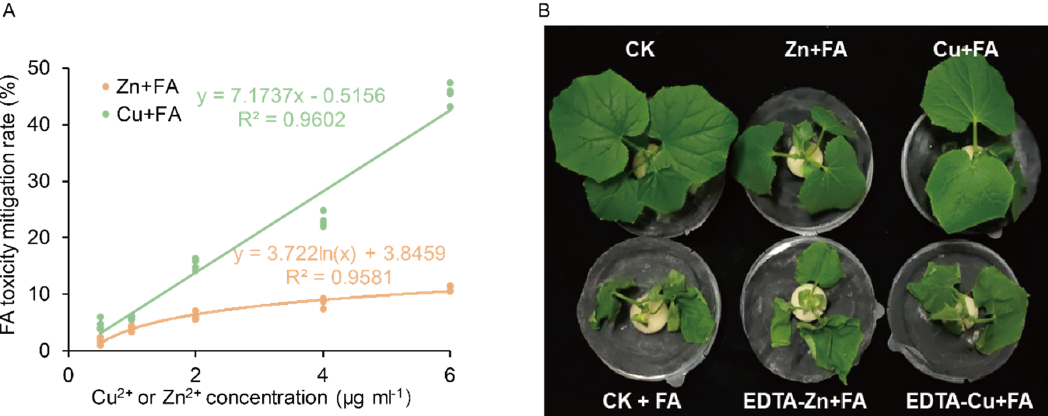
Figure 4. Ions mitigated toxicity of FA in vitro. ( A ) CuSO 4 and ZnSO 4 as resources of Cu and Zn were mixed in the FA aqueous solution (2 µg mL − 1 ) for 24 h. Zn or Cu concentrations were 8, 16, 32, 64 and 96 µM. ( B ) CuSO 4 aqueous solution (200 µM) or ZnSO 4 aqueous solution (480 µM) or EDTA-Cu (200